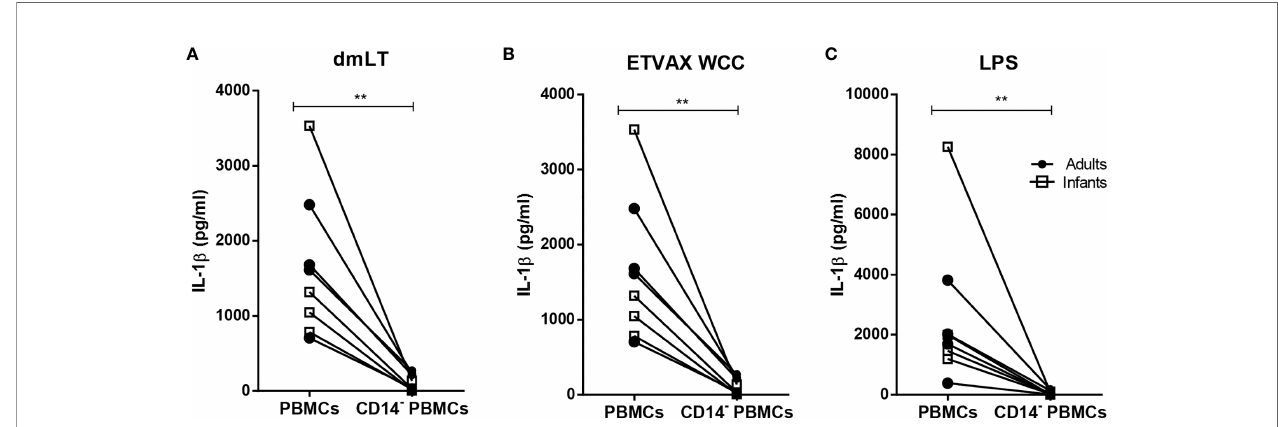
FIGURE 5 | IL-1 b production from PBMCs depleted of CD14+ monocytes in response to dmLT, ETVAX WCC and LPS. IL-1 b concentrations in cultures with PBMCs and PBMCs depleted of CD14 + monocytes from adults (n = 4, closed symbols) and infants (n = 5, open symbols) stimulated with (A) dmLT (20 µg/ml), (B) ETVAX WCC (200,000 bacteria/ml) or (C) E . coli. O111:B4 LPS (10 ng/ml). Each symbol and line represent data from one participant. Statistical analysis was performed using the Wilcoxon matched-pairs signed rank test. ** P < 0.01.